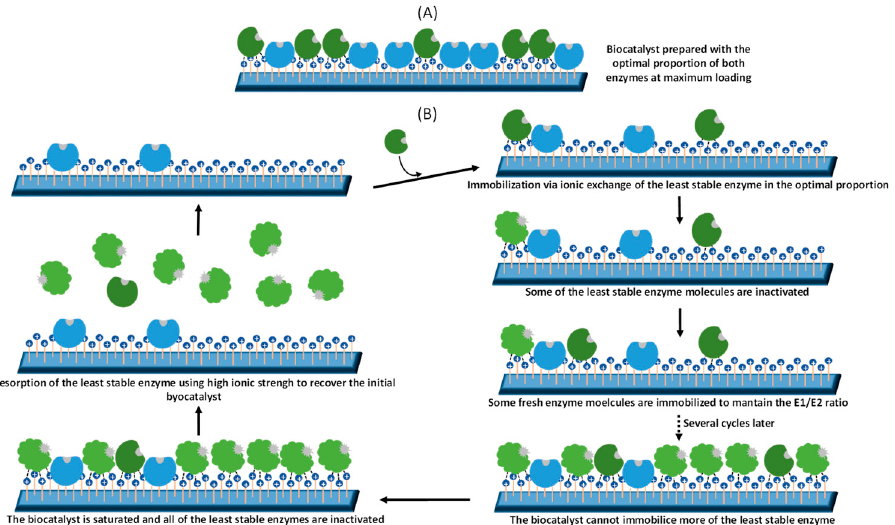
Figure 13. Compatibility of the combi-biocatalysts prepared following Figure 3 with the strategy of using an enzyme loading under the maximum and adding more of the least stable enzyme when required, but with the possibility of reusing the most stable enzyme to prepare more combi-biocatalyst. ( A ) Biocatalyst prepared under the optimal initial conditions at the maximum loading. ( B ) Biocatalyst prepared considering the inactivation of the least stable enzyme to keep the optimal E1/E2 rate ratio.